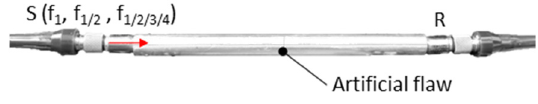
Figure 6. Experimental setup—longitudinal waves.